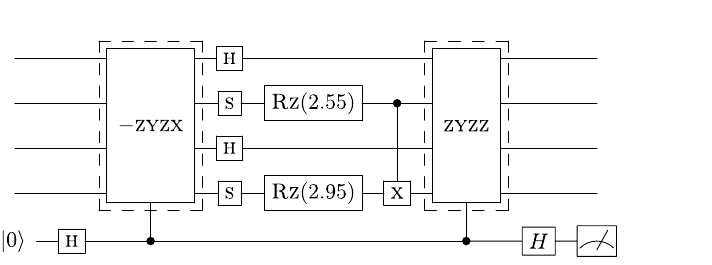
Figure 7. Visual example of “pushing” the checks through the circuit. We start with ˜ C 2 and find ˜ C 1 . No multiplication is performed since the propagation of the ˜ C 2 gate is determined through lookups of predetermined commutation relations.